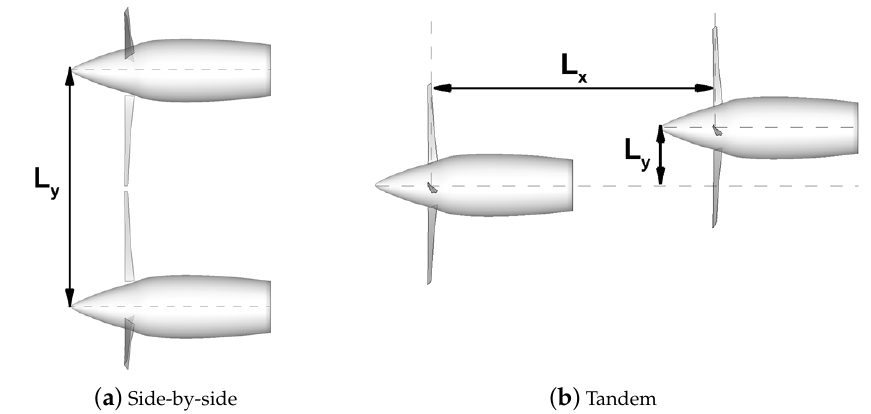
Figure 5. Layout of the interacting propellers configurations investigated by numerical simulations.